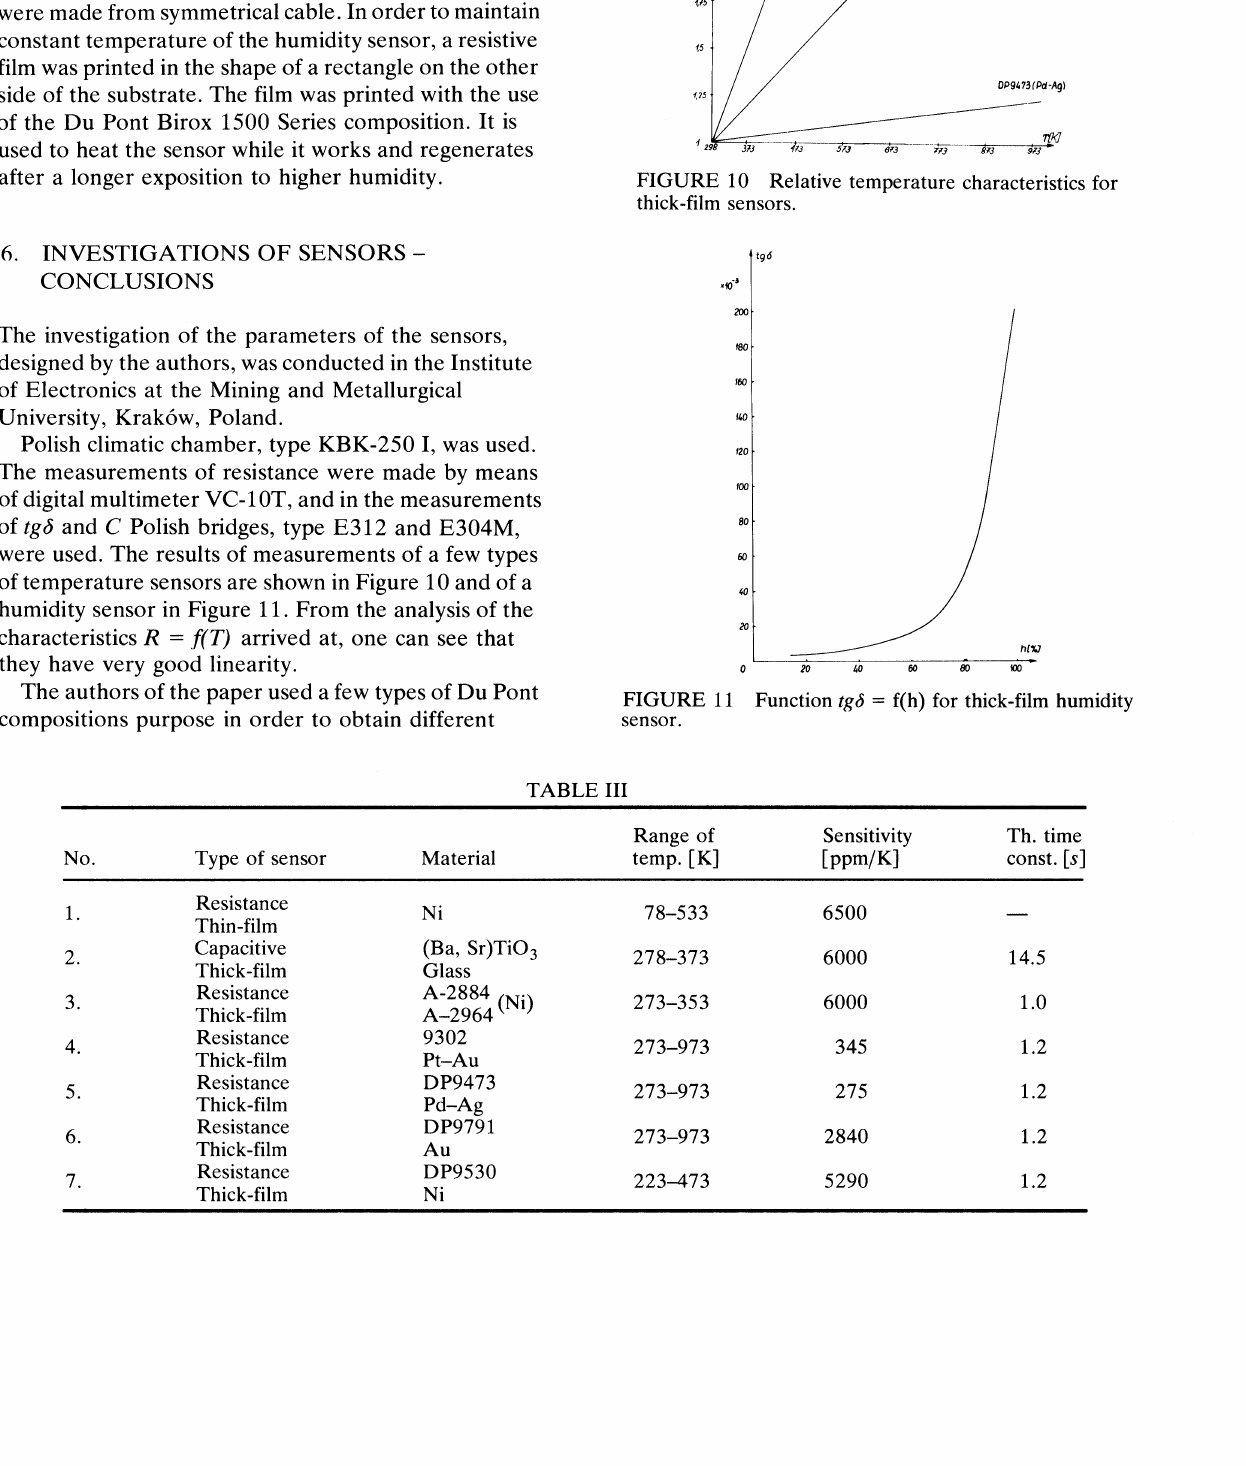
FIGURE 11 Function tg6 f(h) for thick-film humidity